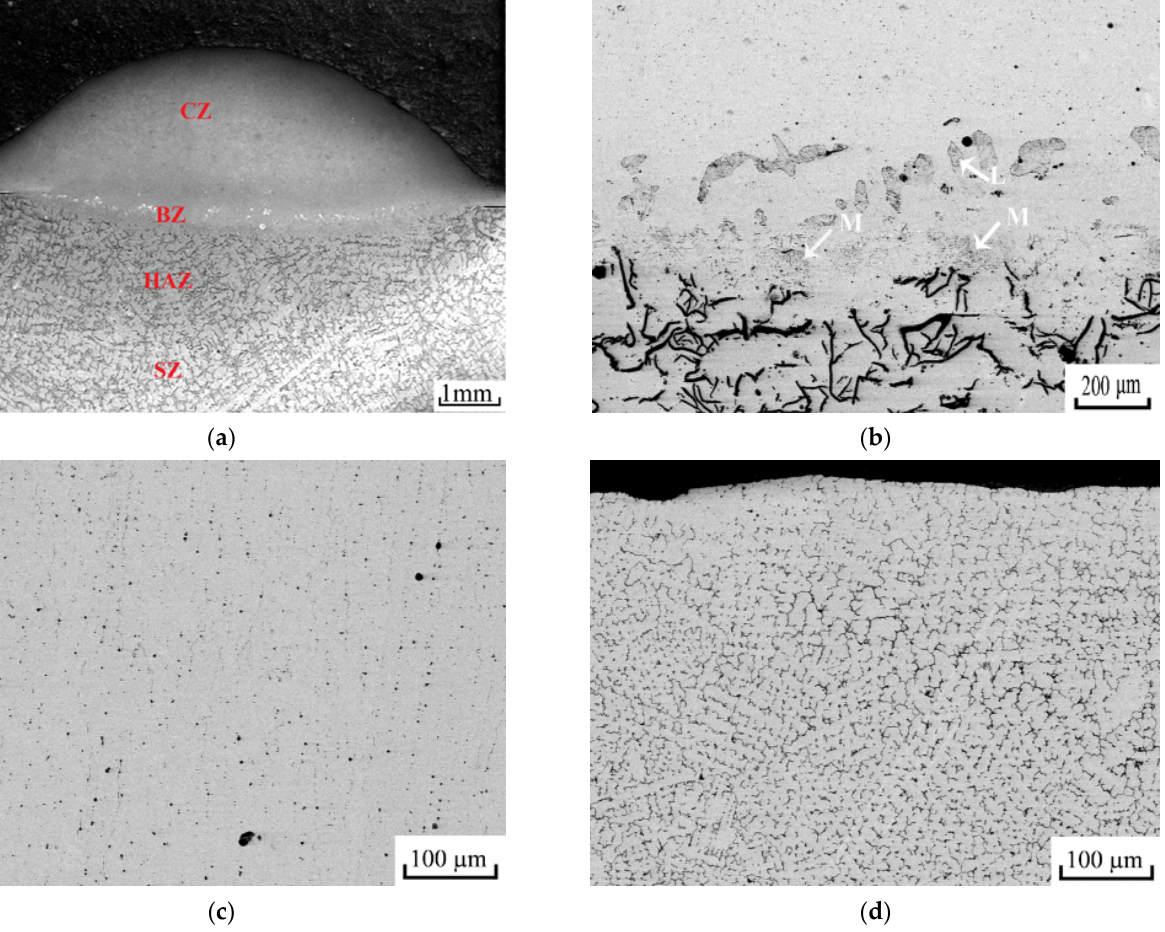
Figure 4. Cross-sectional microstructure of CoCrFeNiMn HEA coating at 70A plasma current: ( a ) global morphology with coating zone (CZ), bonding zone (BZ), heat affected zone (HAZ) and substrate zone (SZ), ( b ) bonding zone with martensite (M) and ledeburite (L), ( c ) coating zone, ( d ) coating zone after deep etching.